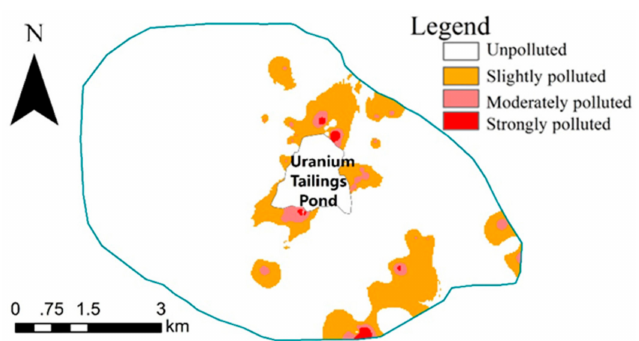
Figure 6. The continuous distribution of